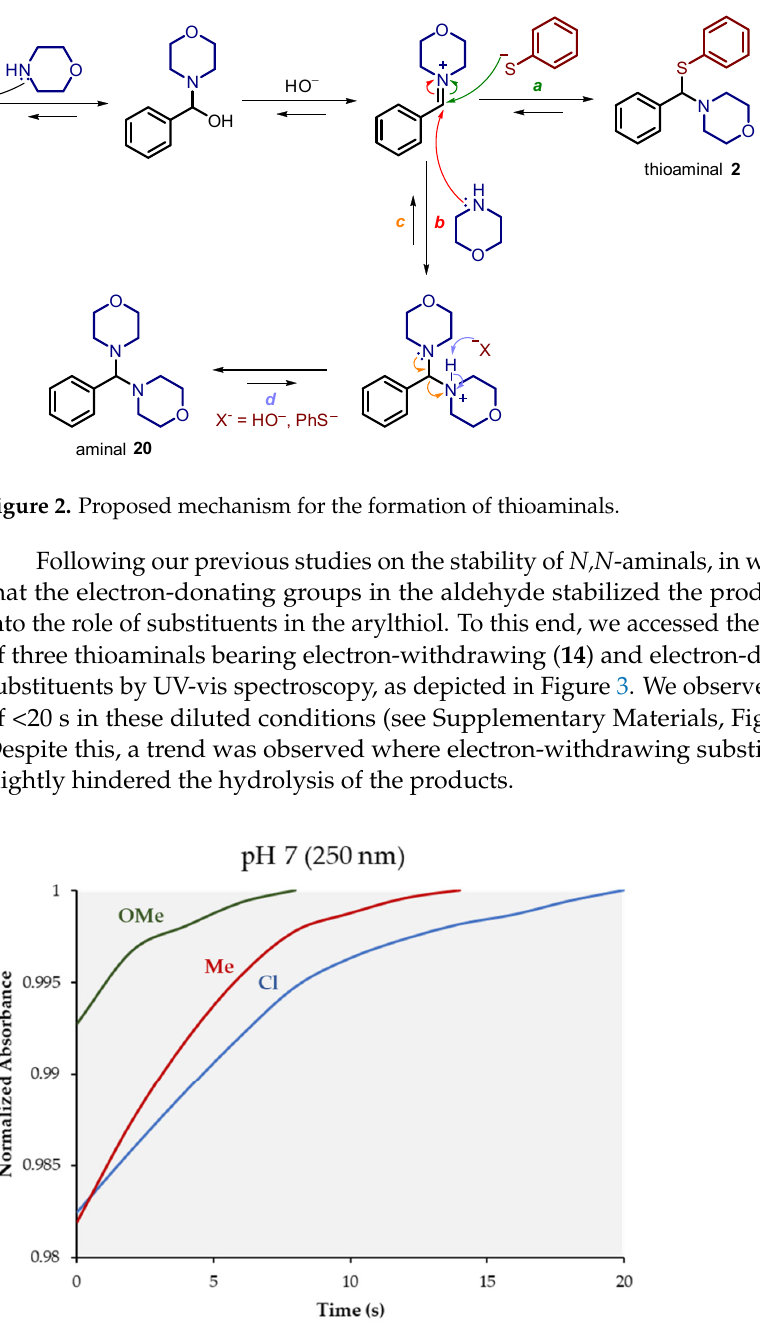
Figure 3. Hydrolysis evaluation by UV ‐ vis spectroscopy of thioaminals 9 , 11 and 14 .